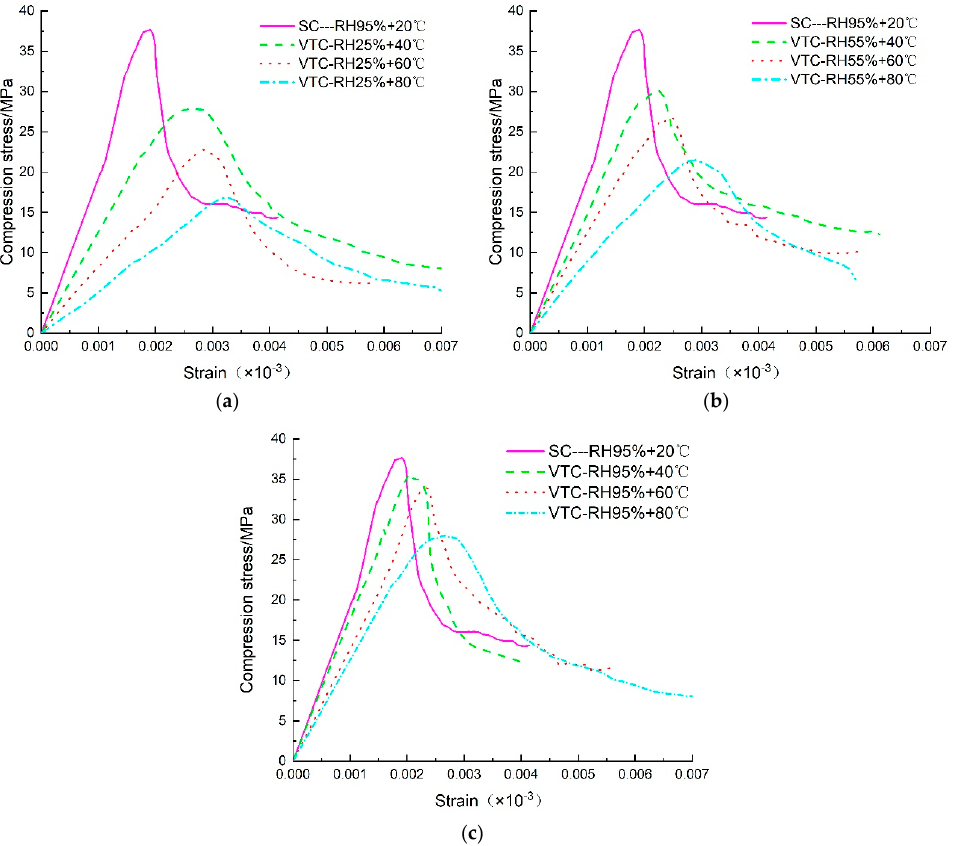
Figure 8. Compressive stress-strain curves under different curing conditions. ( a ) SC vs VTC-RH25%, ( b ) SC vs VTC-RH55%, ( c ) SC vs VTC- RH95%.